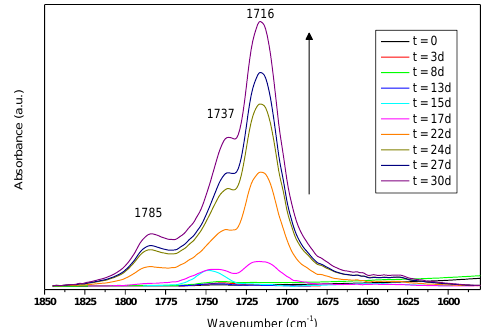
Figure 5. FT-IR spectra of EOC collected during oxidation process. The spectra were normalized to the band at 720 cm −1 (methylene rocking) characteristic of the polymer matrix.